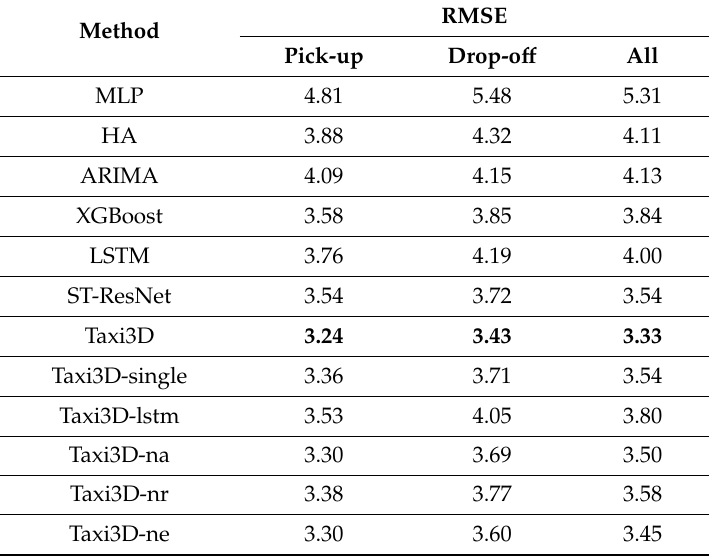
Table 1. Performance comparison among di ff erent